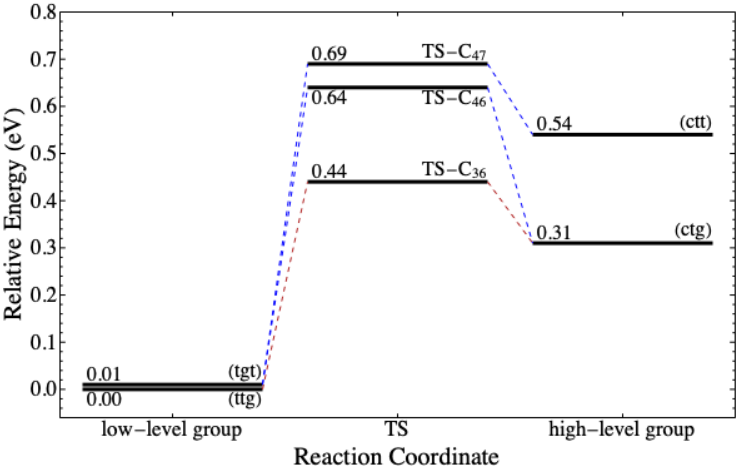
Figure 8. The reaction coordinates from low- to high-level groups of ACh + conformers: The TS between ACh + (ttg) and (ctt) is almost 3 eV, and it is not displayed for the sake of